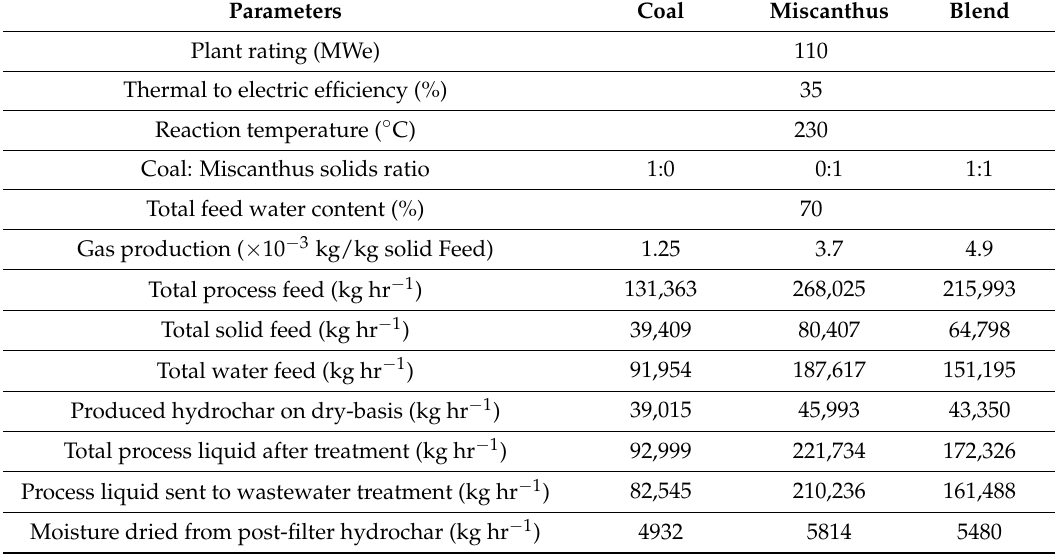
Table 4. Experimental data and flowrates used for overall material and energy balances for equipment